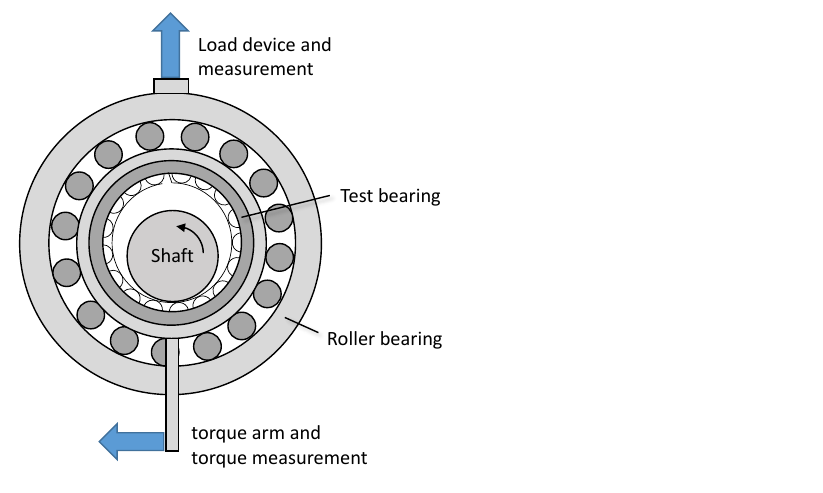
Figure 1. Enhanced design of a test rig for the start-up measurements according to